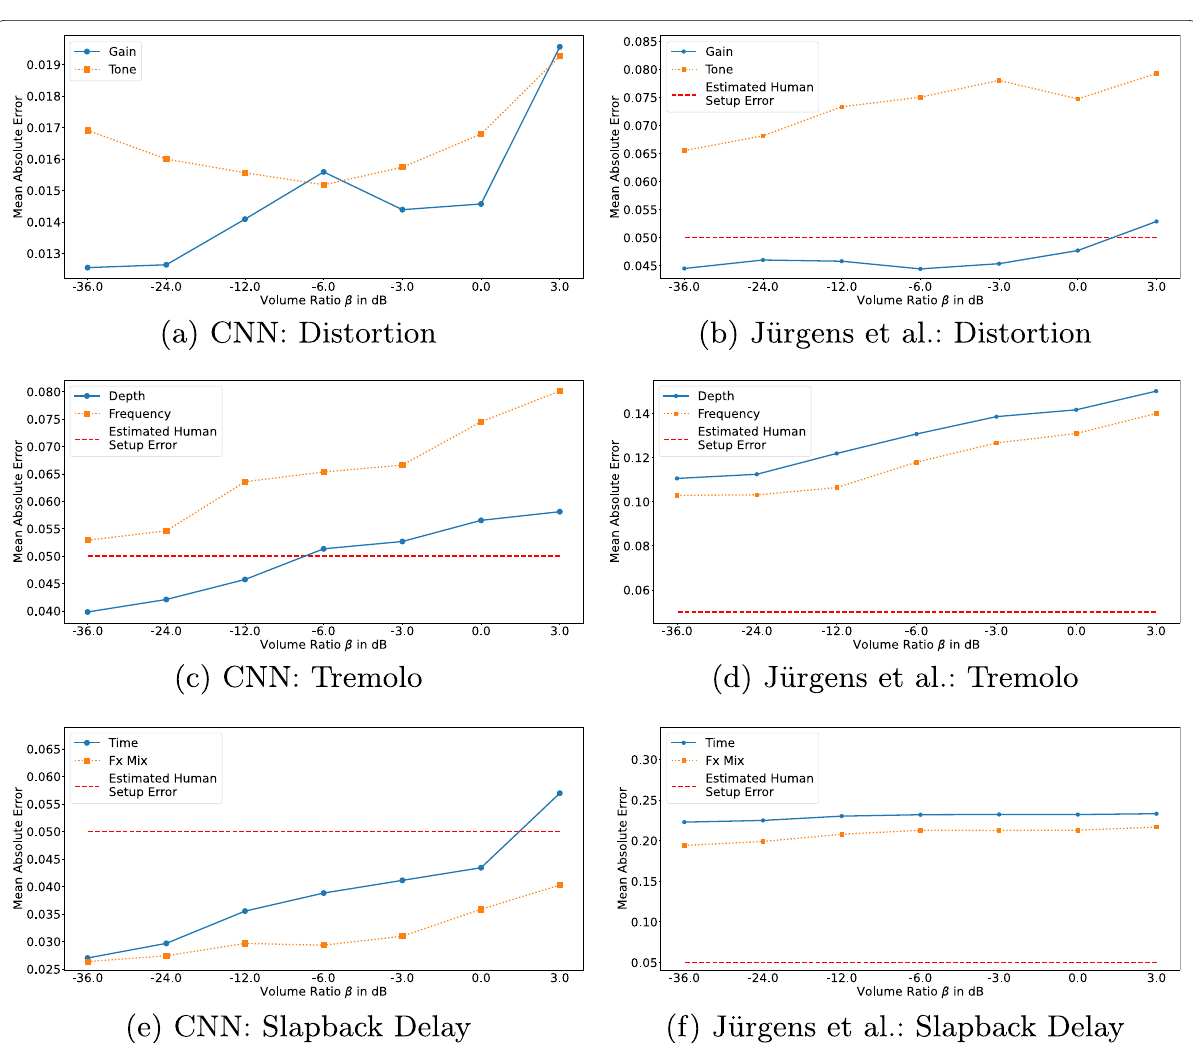
Fig. 7 Mean absolute error of the parameter extraction of the convolutional neural network across mixing volume for the slapback delay effect and each of the four investigated time-frequency representations. Qualitatively identical results were obtained for the distortion and tremolo effect